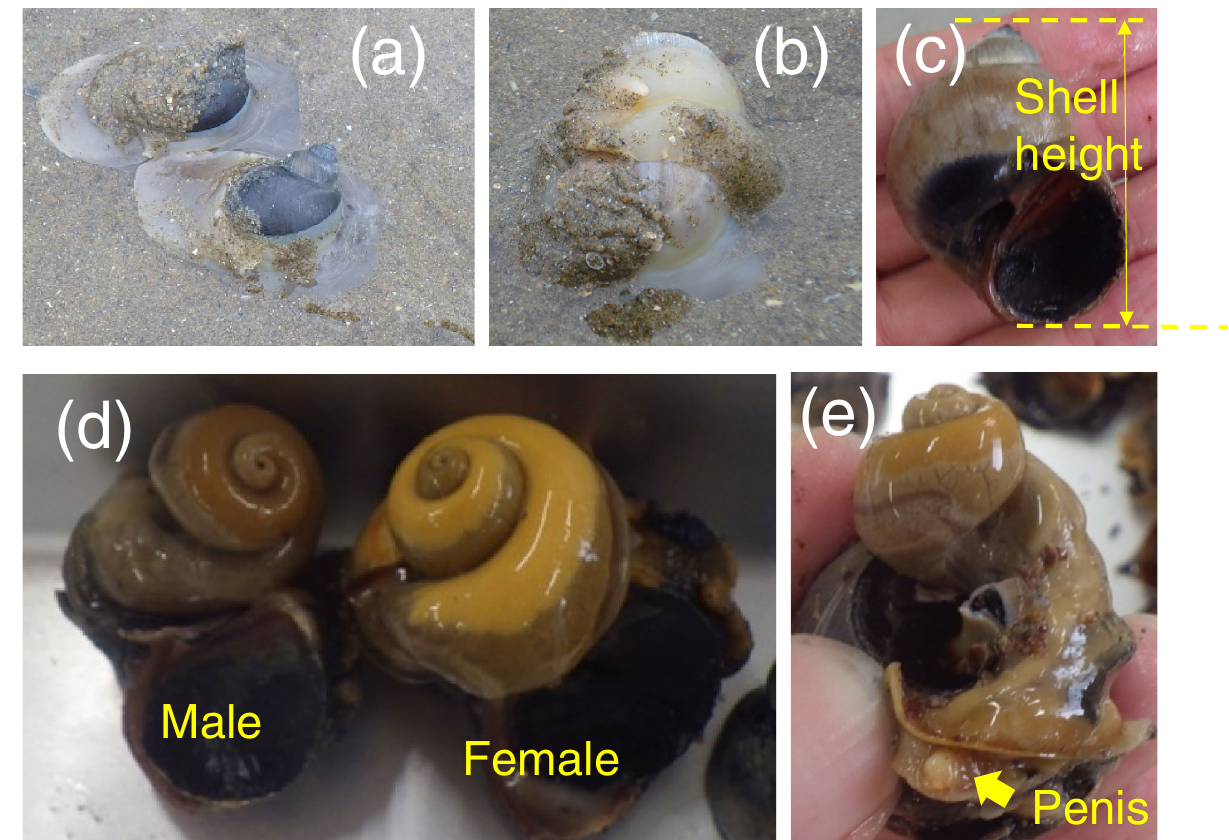
Figure 1. Photographs of Laguncula pulchella . ( a ) Crawling behavior of two individuals. ( b ) Shell mounting behavior. ( c ) Shell height (SH). ( d ) Soft body of a male and female after removing large part of the shell. ( e ) Male individual having a